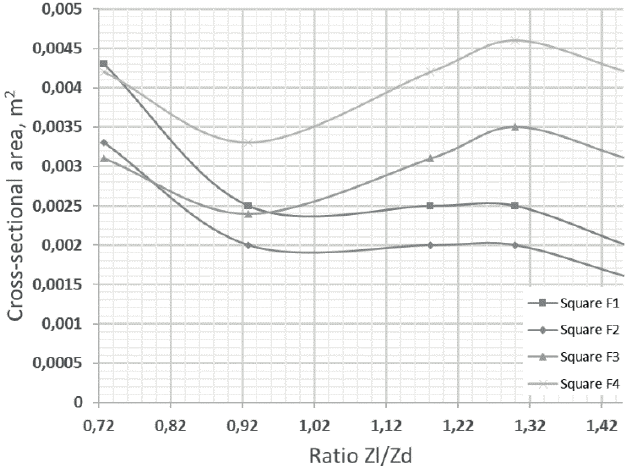
Fig. 6. The dependence of the ratio of the impeller vanes and diffuser vanes to the flow area of the channels.